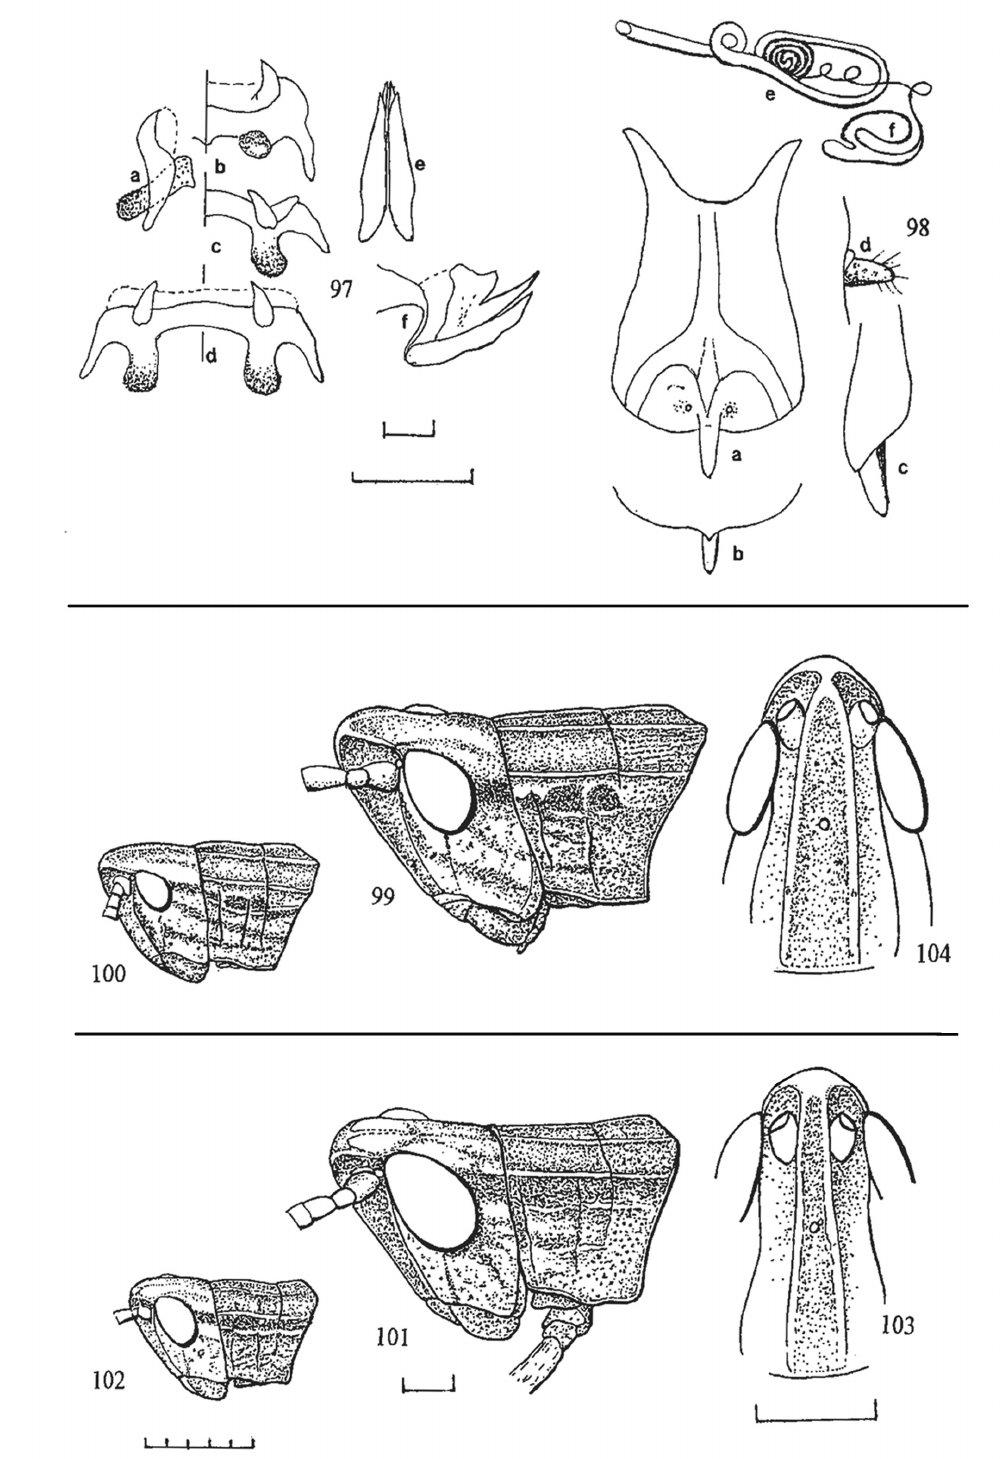
Figs 97–104. Duronia genus group. Figs 97–98. Duronia chloronota phippsi n. subsp .: 97. Male genitalic structures: A–D. Epiphallus, A. Laterally, B–D. Dorsally and dorso-posteriorly ( B–C. Right half only); E–F. Aedeagal valves ventrally and laterally from right side, re- spectively. 98. Female genitalic structures: A. Subgenital plate dorsally; B. Apex of same ventrally; C. Idem, laterally from right side; D. Cercus; E. Spermathecal duct; and F. Spermatheca. Figs 99, 100, 104. Oxyduronia anablepioides gen.n. et sp.n . 99–100. Oblique aspect of head and pronotum; 99. Male from left side; 100. Female from left side; 104. Male frontal ridge. Figs 101–103. Leopardia bivittata Baccetti. 101, 102. Oblique aspect of head and pronotum. 101. Male from left side; 102. Female from left side; 103. Male frontal ridge. All scale lines under Figs 97, 101, and 103 represent 1 mm – lowermost scale applies to Figs 97 A–F, the uppermost to Figs 98 A–E; that below Fig. 101 applies also to Fig. 99; that below Fig. 103 also applies to Fig. 104. Scale under Fig. 102 represents 5 mm and applies also to Fig.